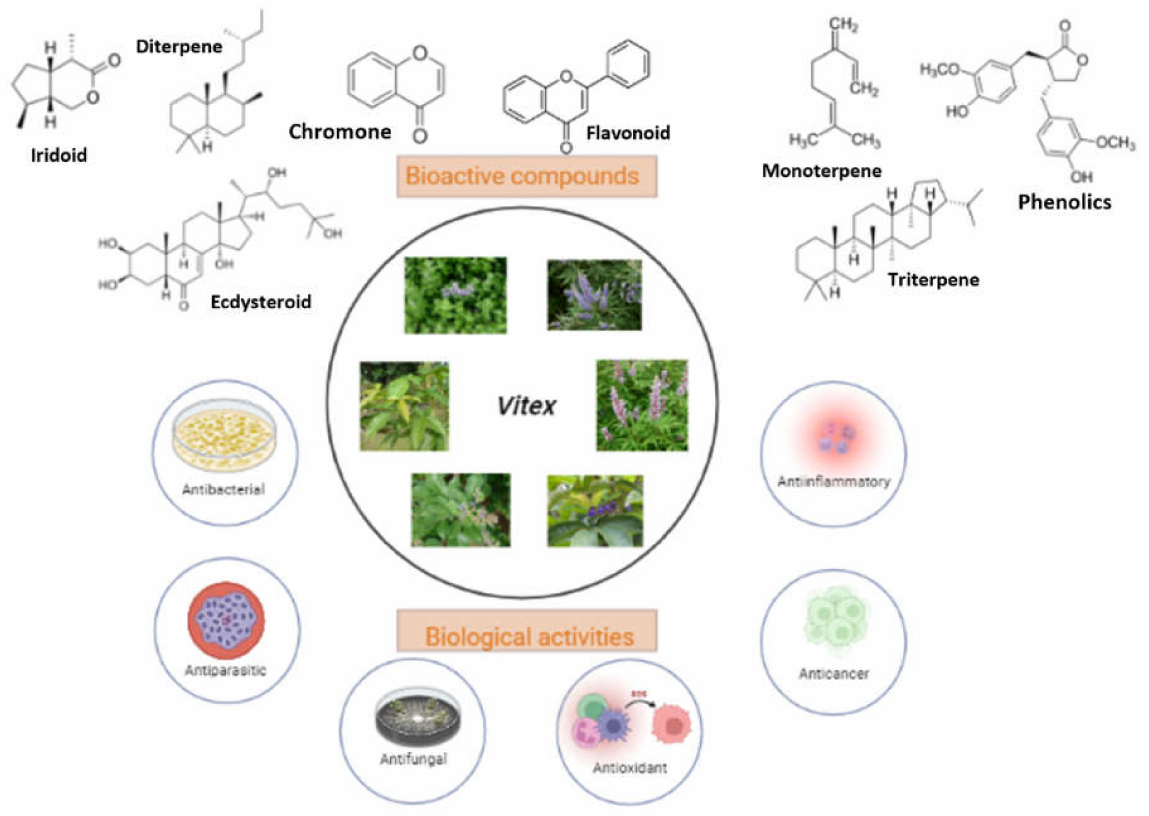
Figure 1. Bioactive secondary metabolites and biological activities of Vitex